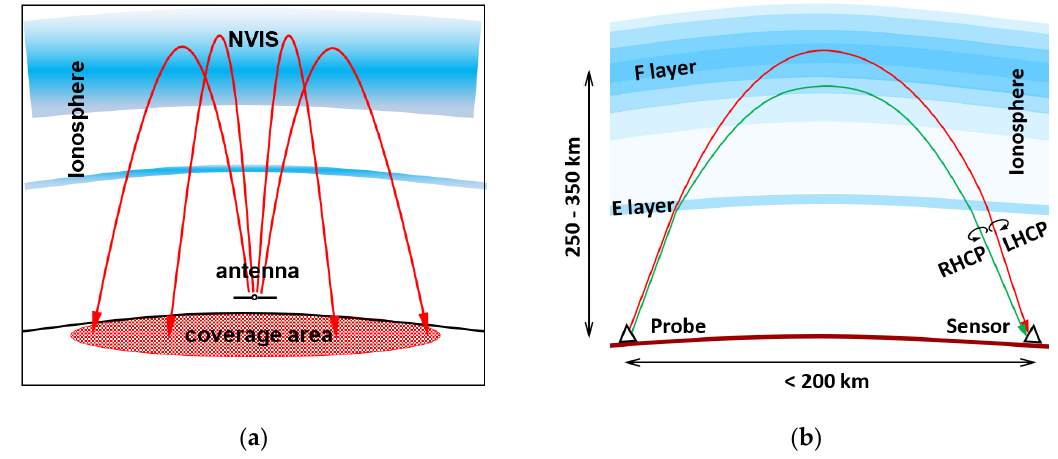
Figure 2. ( a ) Near Vertical Incidence Skywave (NVIS) propagation; ( b ) Magneto-ionic propagation: ordinary (red) and extraordinary wave (green). Polarization is shown for the northern hemisphere.